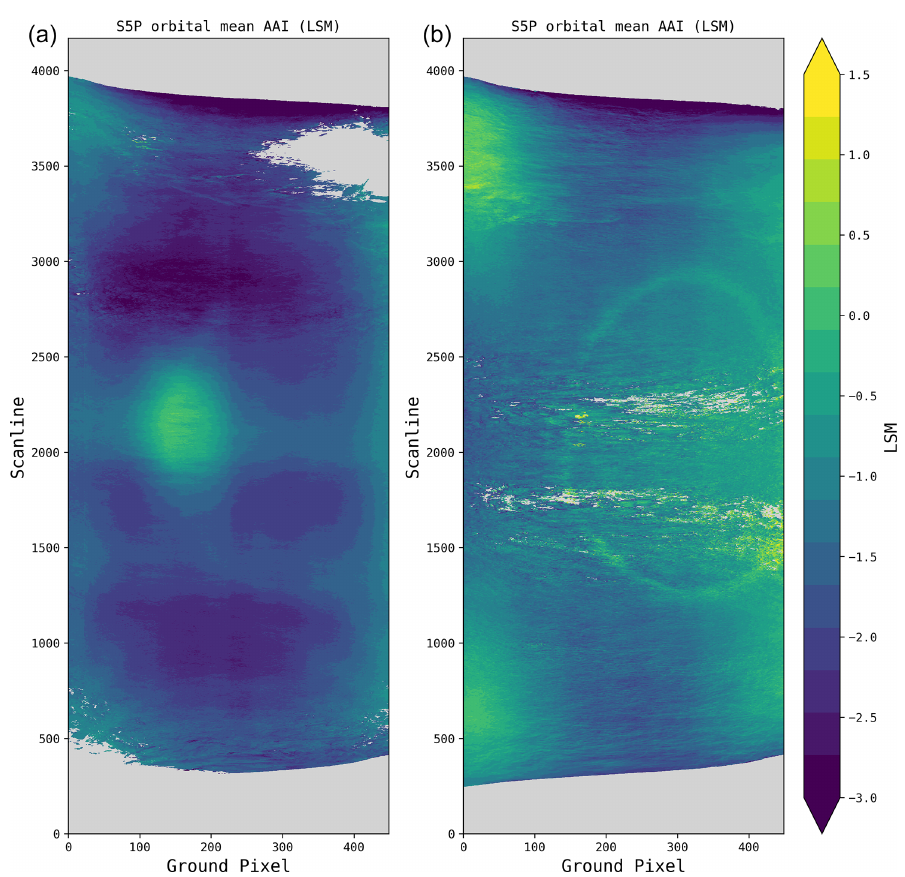
Figure 5. Orbital distribution of the TROPOMI AAI based on retrieved scene albedo at 380nm which is strongly correlated with cloud presence. Scenes with few to no clouds (0.0 <A sc < 0.2) are shown in panel (a) , and cloudy scenes (0.6 <A sc < 1.0) are shown in panel (b) . Here the same orbits are used as in Fig.